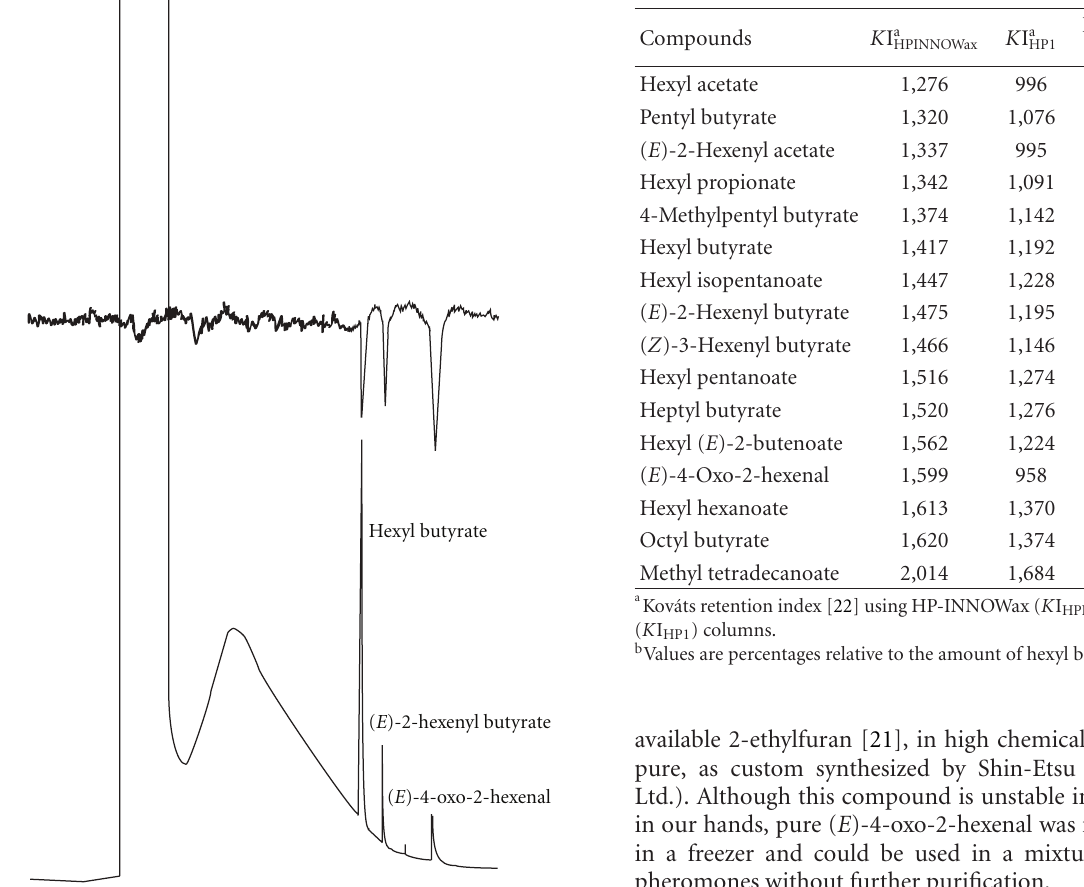
Table 1: Compounds identified in extracts of female Stenotus rubrovittatus